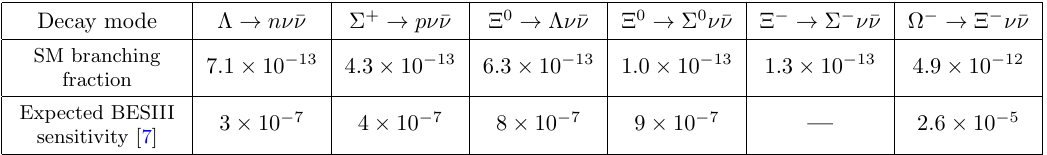
Table 2 . The branching fractions of j (cid:1) S j = 1 hyperon decays with missing energy in the SM and the corresponding expected sensitivities of BESIII